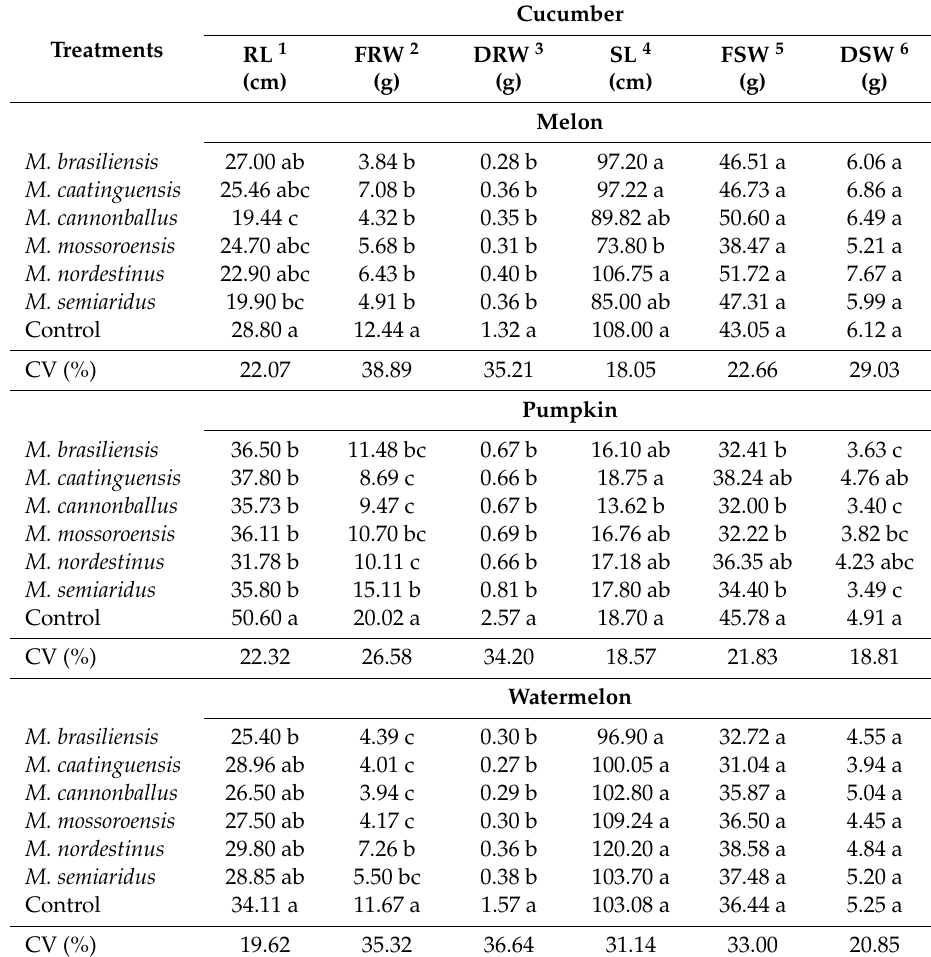
( M. cannonballus ) to 0.95 mg / L a.i. ( M. brasiliensis ). The mean EC 50 for fludioxonil was 0.035 mg / L a.i., and the values of this variable ranged from 0.01 ( M. cannonballus , M mossoroensis , M. nordestinus , and M. semiaridus ) to 0.09 mg / L a.i. ( M. brasiliensis ). Of the fungicides evaluated, those with lower EC 50 for all Monosporascus spp. studied were fludioxonil and fluazinam (0.03 and 0.34 mg / L a.i.,